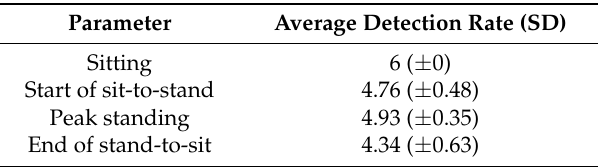
Table 2. Transition detection rates for each point of interest.